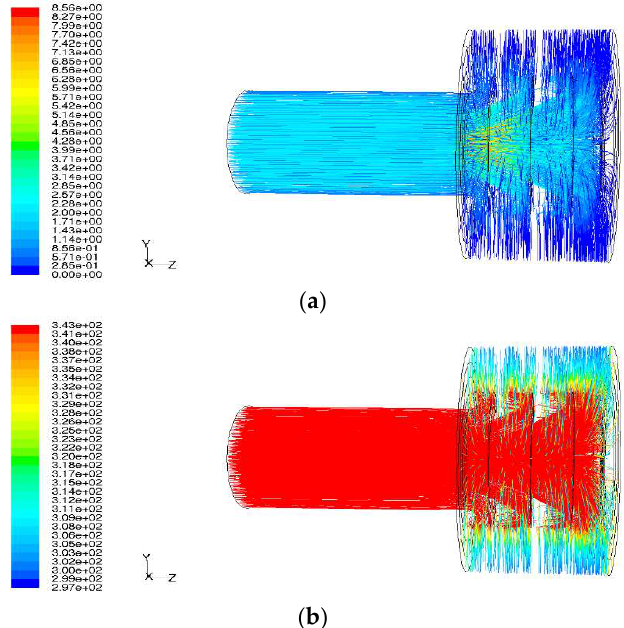
Figure 11. The current line fields inside the cylindrical box with baffles and three layers for the second version (temperature of 343 K = 70 °C): ( a )—velocity (m/s); ( b )—temperature (K) [30]. The effects of an aggressive drying process using high temperatures and low air ve- locities can be seen in Figure 12.